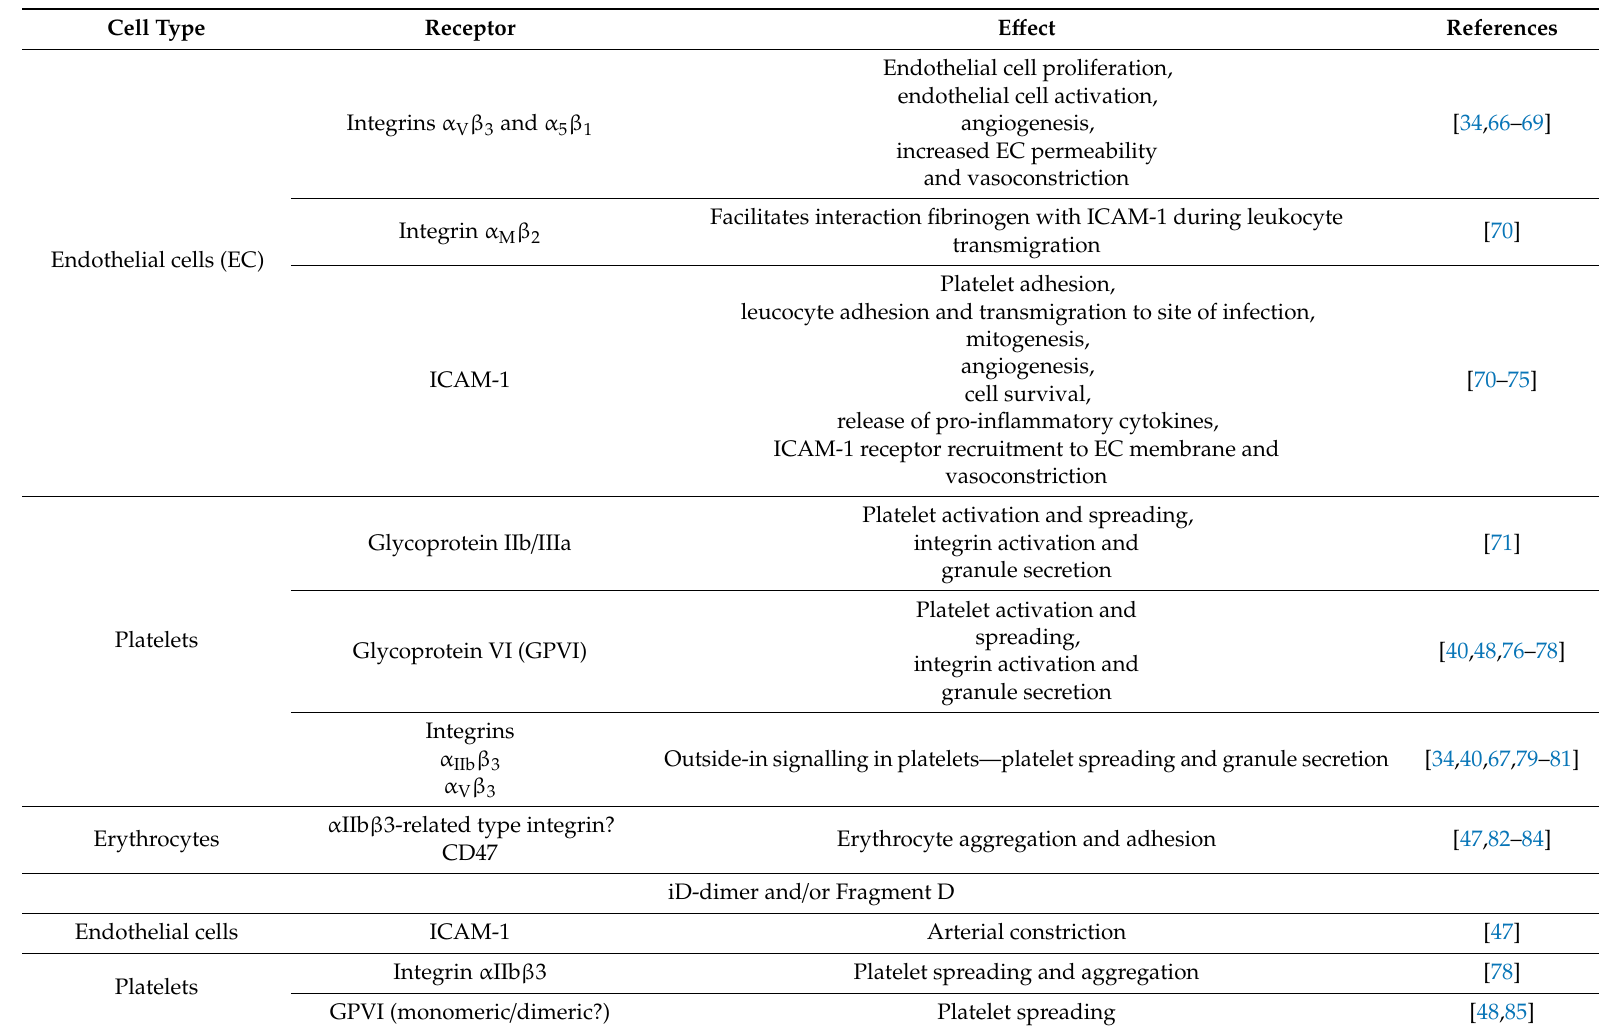
Table 1. Receptors known to bind fibrinogen and D-dimer and the e ff ects they elicit within di ff erent cell